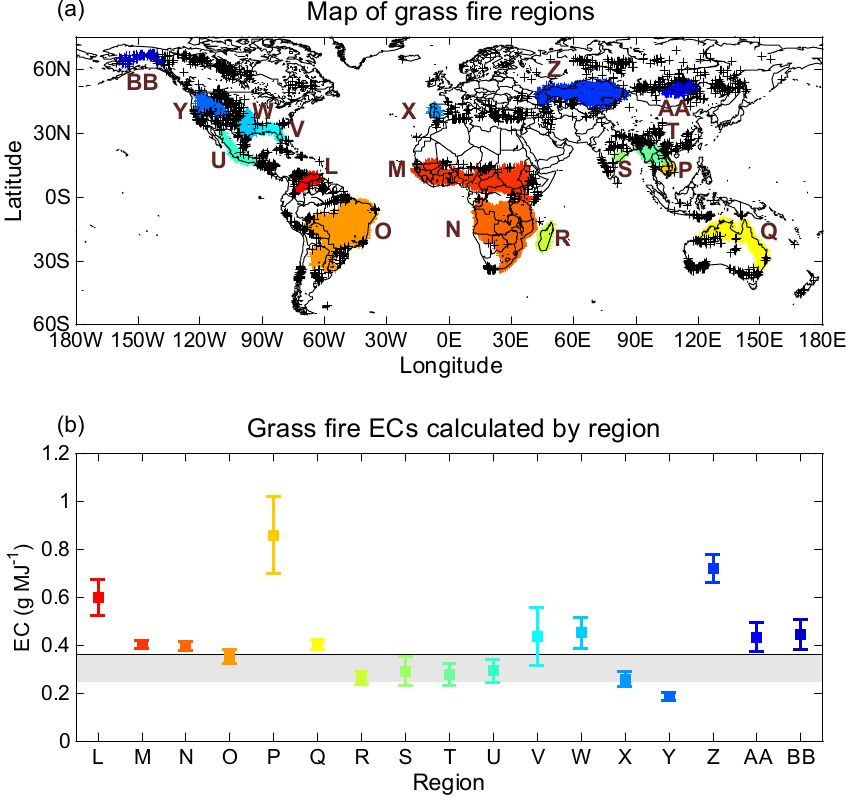
Fig. 4. A map of grass fire regions determined by a clustering analysis (a) and ECs calculated individually for each region (b) . In (a) , black markers identify grass fires belonging to clusters with less than 100 observations. In (b) , the mean grassland biome EC is indicated by the black line, while the range of all mean biome ECs (as presented in Table 2) is indicated in